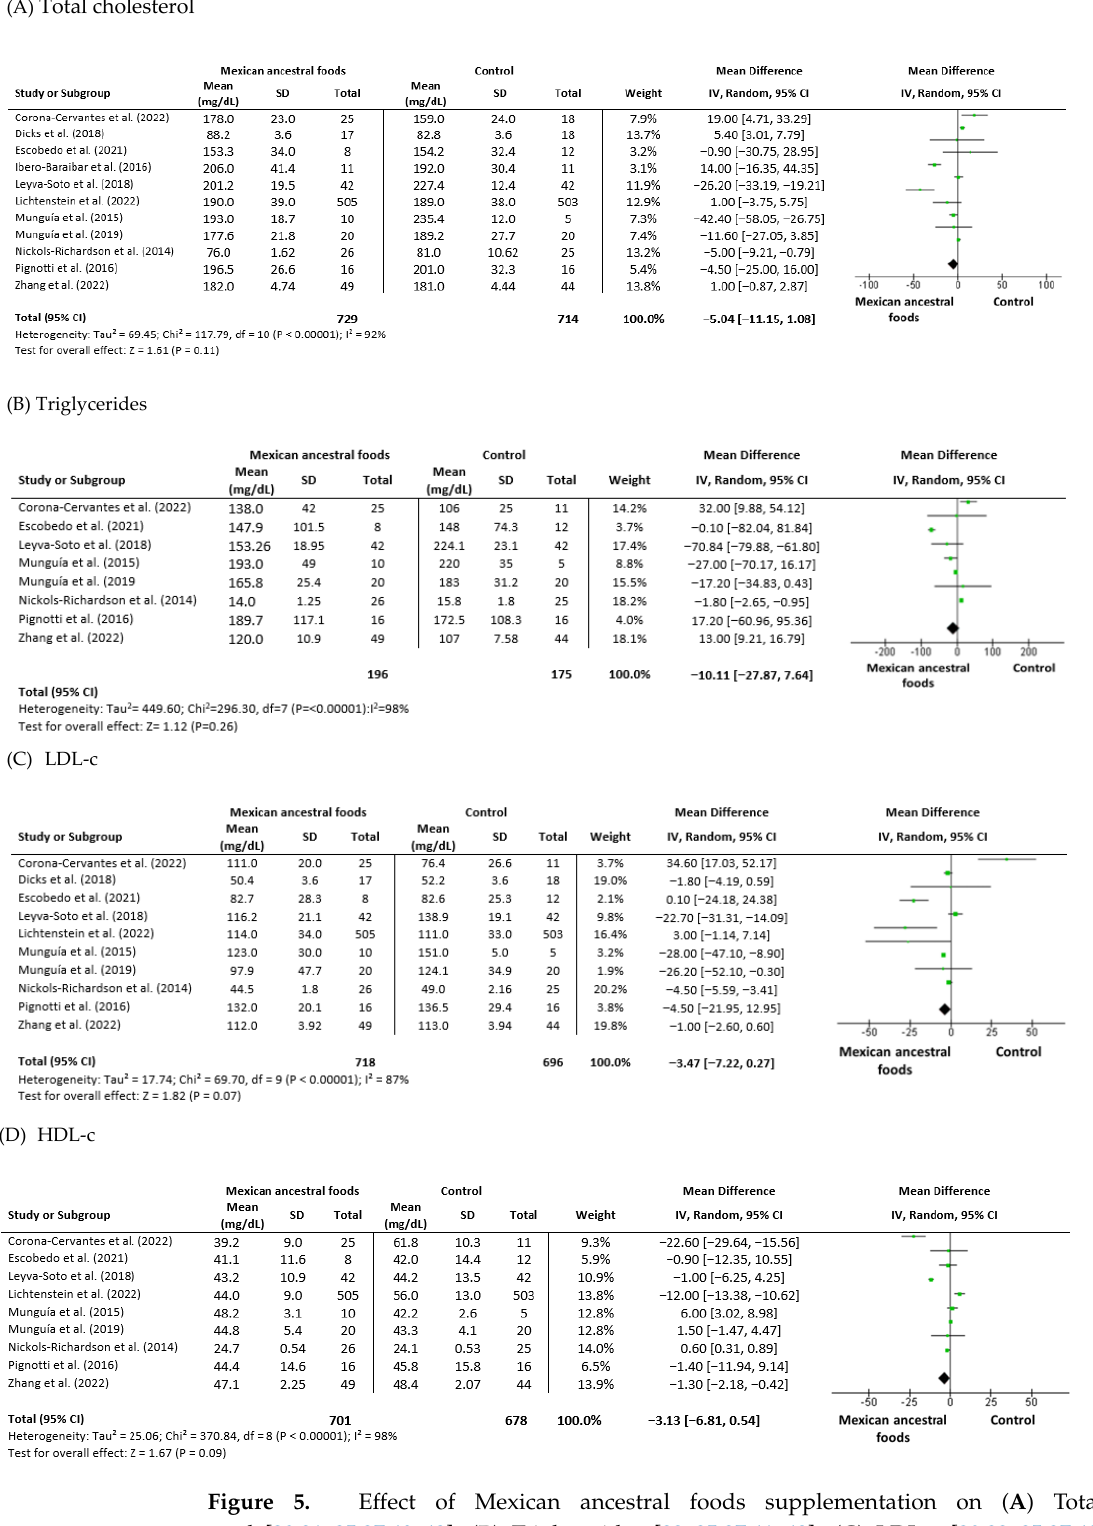
Figure 4. Effect of Mexican ancestral foods supplementation on ( A ) Body weight [30,31,36,38,39,43] ( B ) Body mass index [31,32,34 – 36,38,40 – 43] and ( C ) Waist circumference [31,32,34 – 36,38,40,42,43]. All data are presented as mean ± standard deviation and confidence interval is 95% (CI). Study weights were assigned using the inverse variance method and random-effects model. The diamond ( ) represents the overall effect estimate of the meta-analysis and the green point ( ) represents mean difference of effect measure of each study.